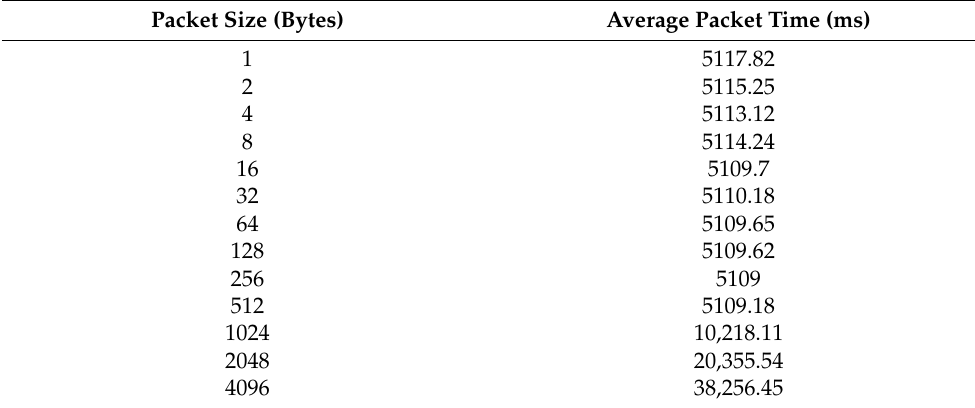
Table 2. WIC UWB GW (CDHU) to WIC UWB node (PDHU) average end-to-end delay.